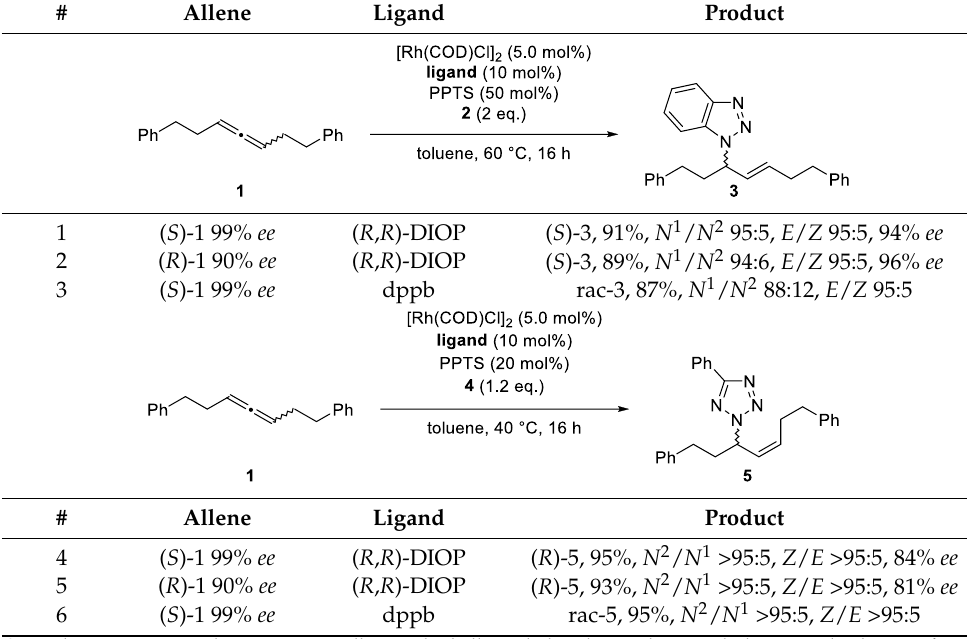
Table 1. Control experiments with enantioenriched allene.